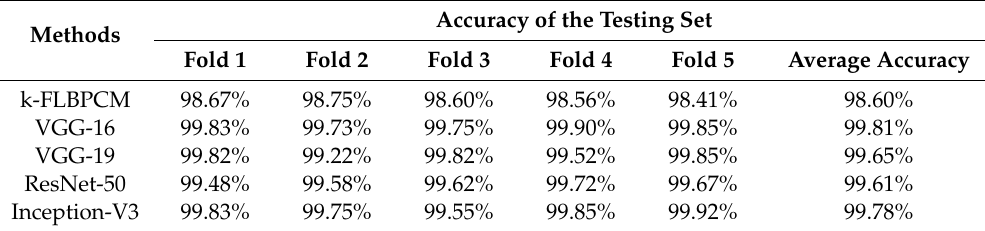
Table 2. Classification accuracies of the test set, in the “bccr-segset” dataset, for di ff erent methods, for a batch size of 32 and dropout 0.5.